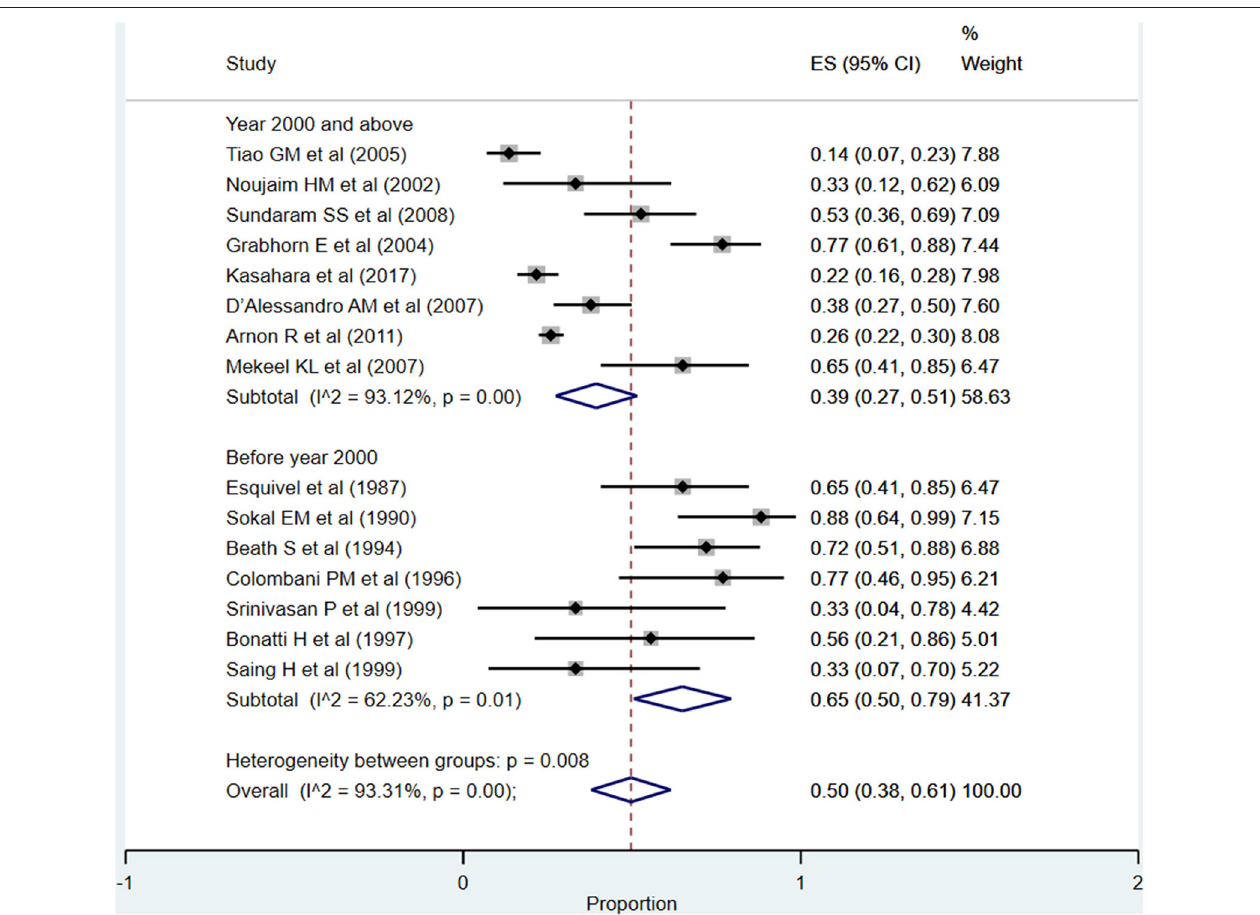
FIGURE 11 | Pooled proportion for infections/sepsis in the included studies.